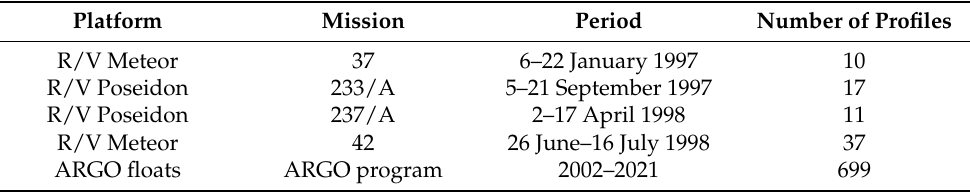
Figure 3. Map of the positions of the reference database profiles (CANIGO and ARGO) and the glider profiles used in the crossover analysis. The red dots correspond to the positions of the glider profiles. The black dots correspond to the positions of the ARGO profiles. The green dots correspond to the positions of the CANIGO stations. Table 1. Oceanographic cruises and ARGO data used to validate glider